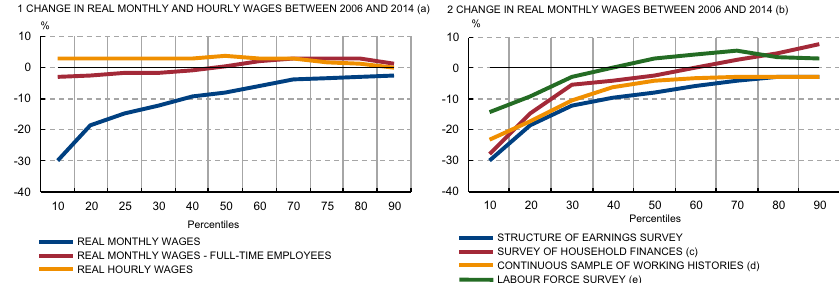
Fig. 7 Changes in wage earnings 2006–2014 by percentile. Sources : See notes. a. Source : National Statistics Institute (EES). b. Sources : National Statistics Institute (EES, EPA), Banco de España (EFF) and Ministry of Employment and Social Security (MCVL). c. Monthly wages calculated from annual wages for indi- viduals in work at the time of the interview in the same sectors of activity as the EES. d. Monthly wages calculated from fiscal module for workers working the whole week. e. Monthly wages associated with main employment in the survey reference week